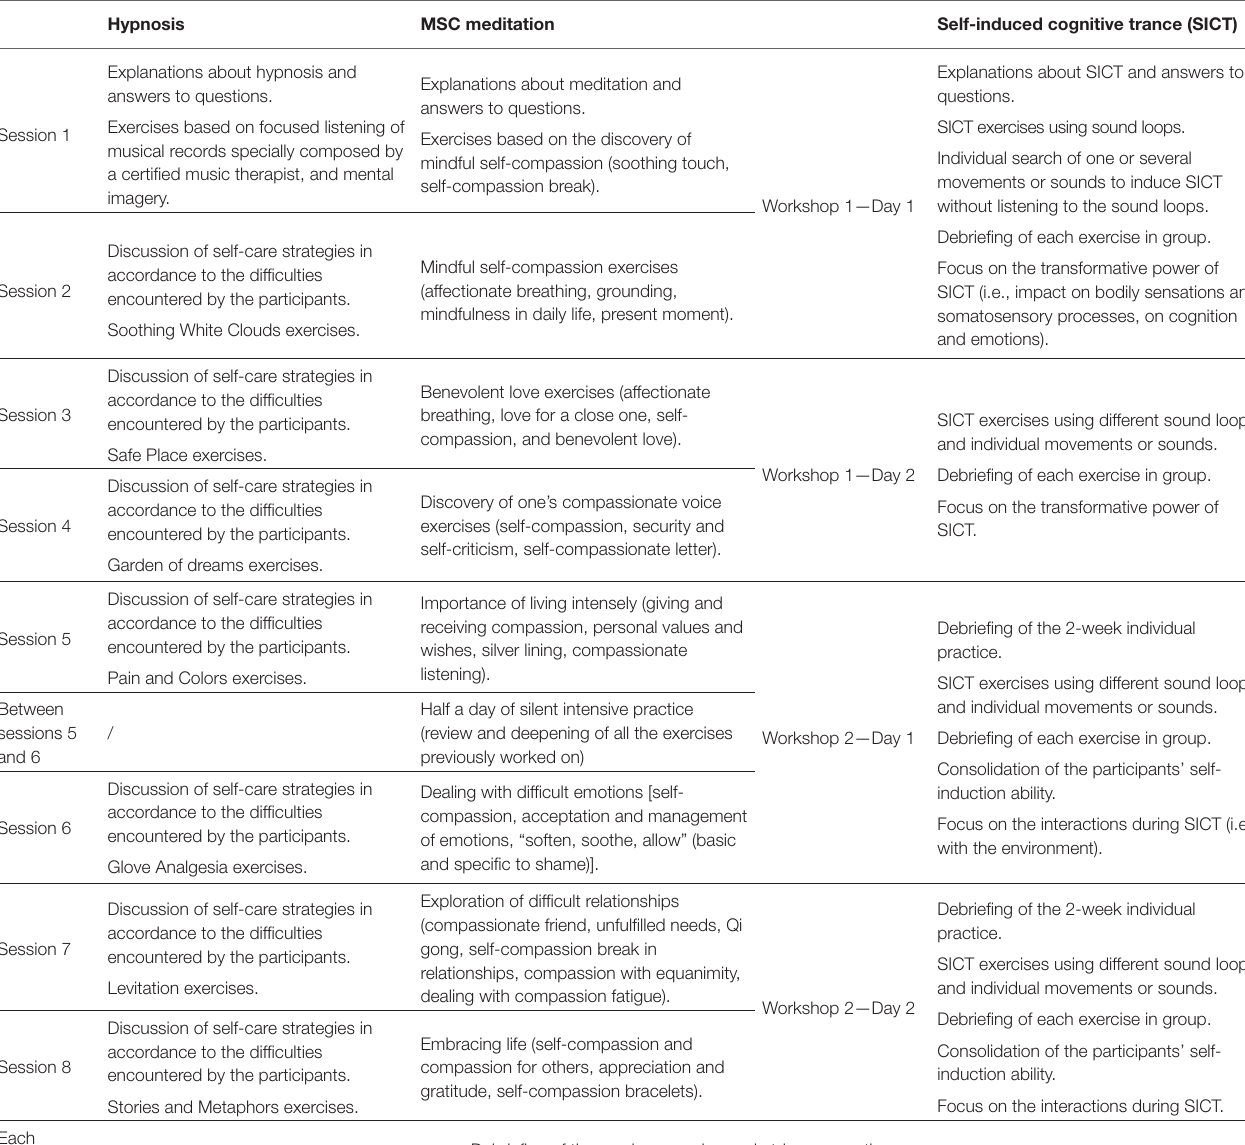
TABLE 2 | Summary of the content of the sessions for each intervention. Hypnosis MSC meditation Self-induced cognitive trance